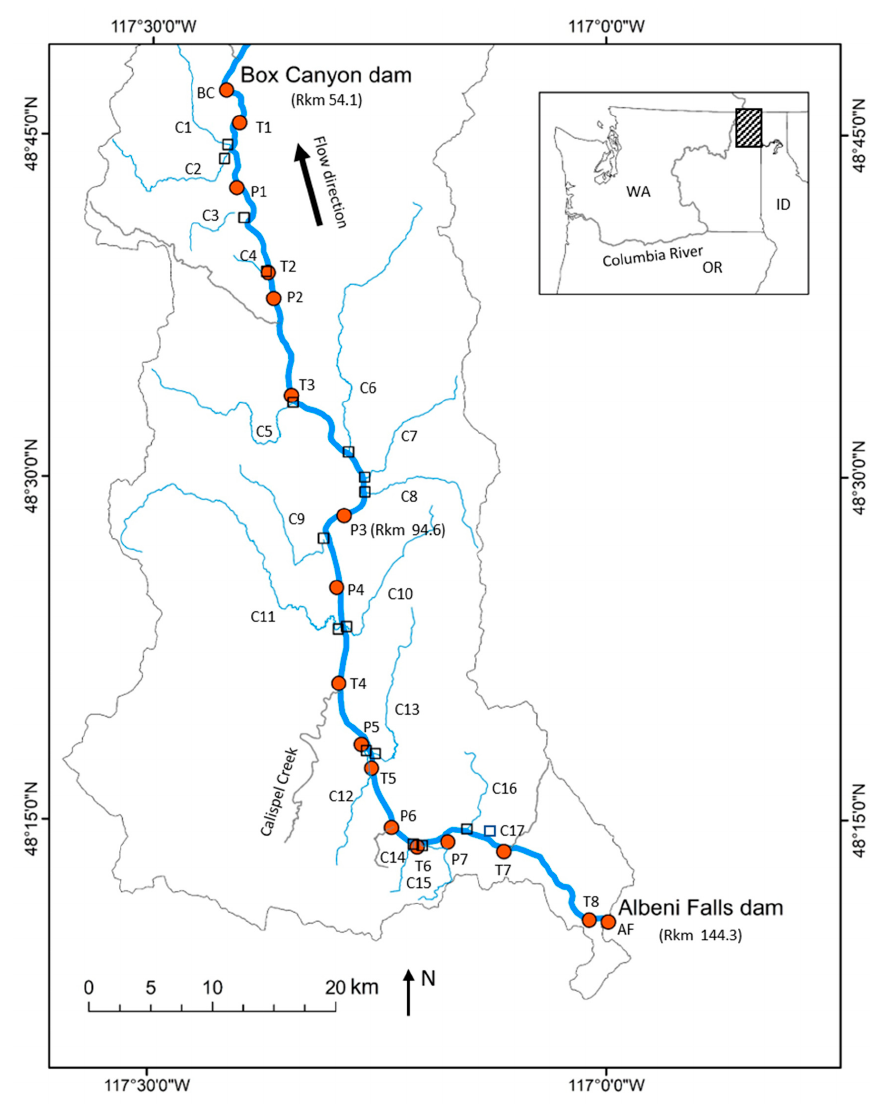
Figure 1. Pend Oreille River study area in eastern Washington and northern Idaho, USA. Orange circles are main stem sites labeled as either P (peaks) or T (troughs), and hollow squares are tributary confluences (C) included in the study. Gray tributaries were sampled but not included in analysis because of missing data. Black arrow describes direction of flow from south to north.